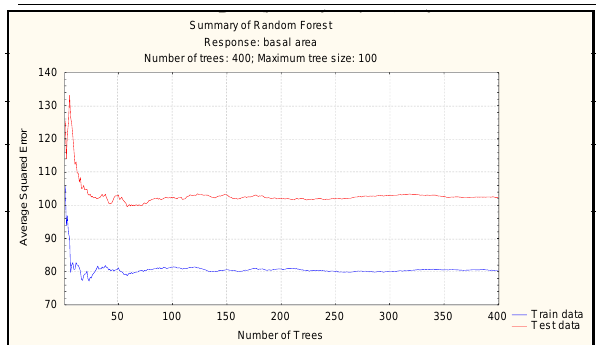
Figure. 3: average squared error changes in the number of trees for basal area Table. 3: The evaluation of the random forest to determine the most appropriate parameter for basal area using spectral data